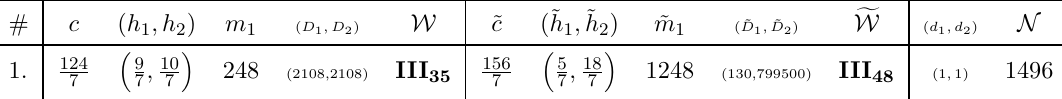
Table 20. IVOA-type pairing, c H = 40 with ( n 1 , n 2 ) = (2 , 4) . The meromorphic character is j 2 3 ( j − 1240 + N ) with N given in the last column of the table.